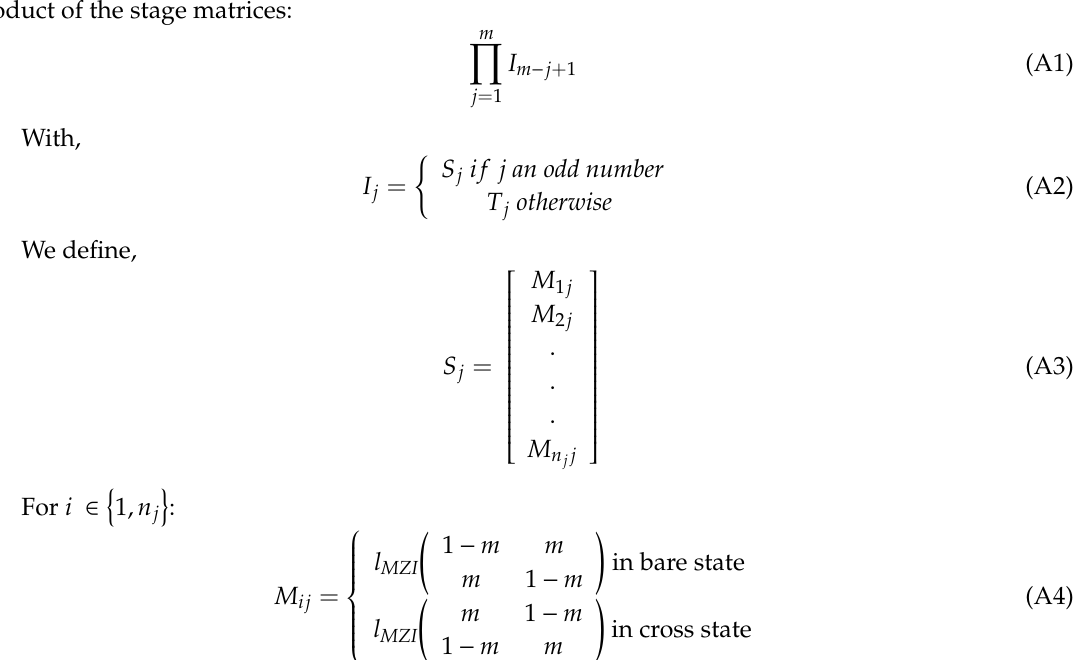
Figure A1. Switch network represented by a matrix decomposition of multi-stage of MZIs and